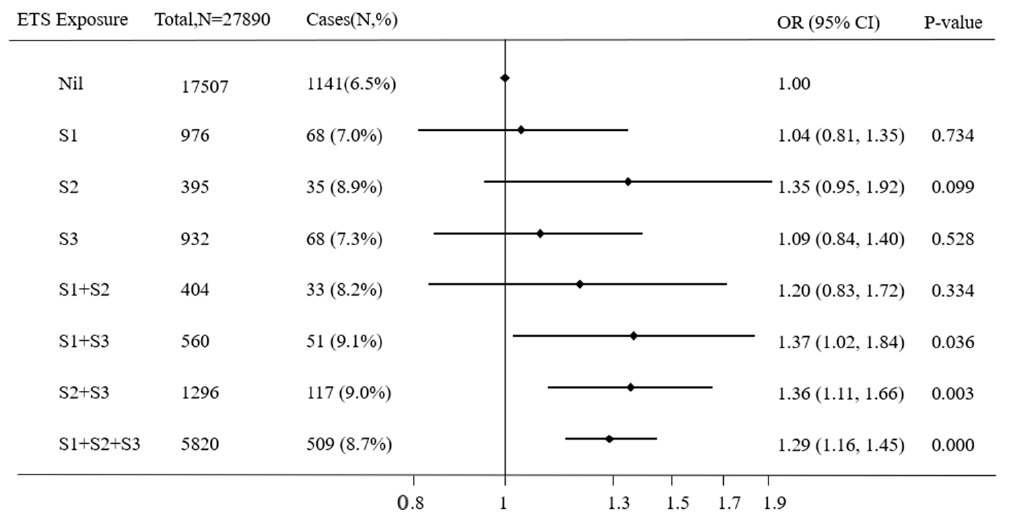
Table 2. The dose-response relationship between total score of ETS exposure based on the number of exposing cigarettes smoked per day (TSETS-NECSPD) and astigmatism.